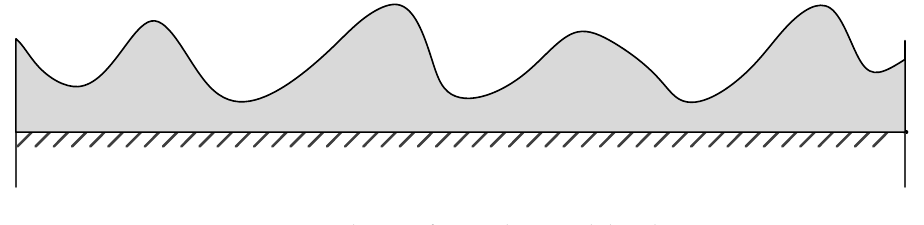
Figure 13. Random surface with normal distribution.